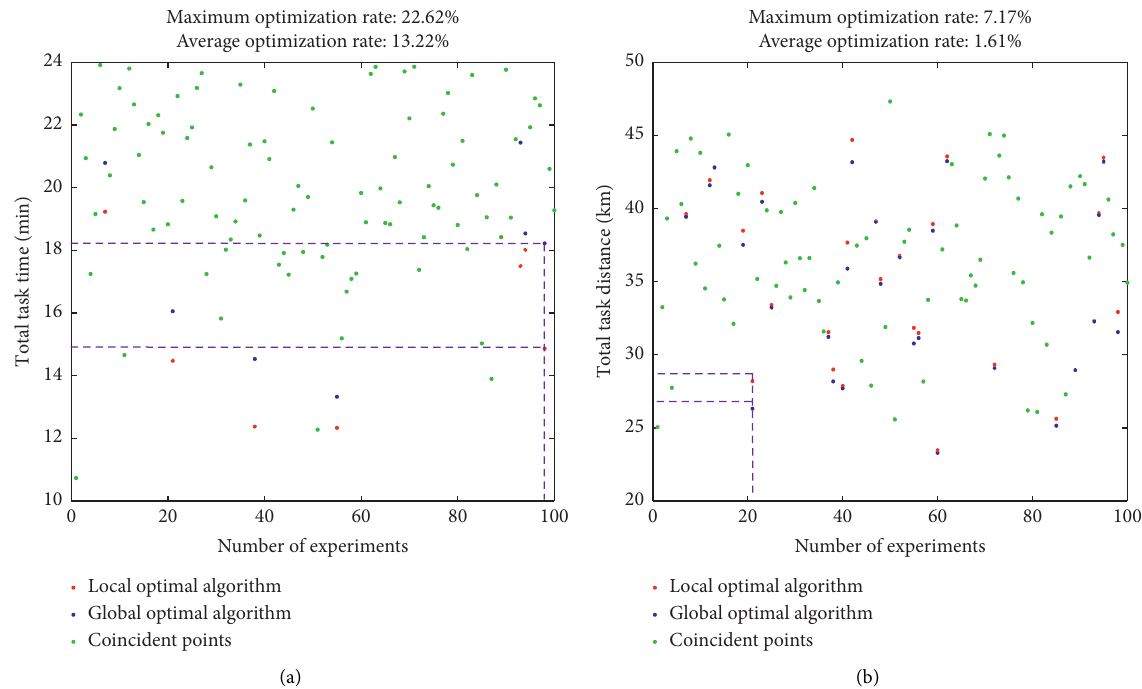
Figure 9: The results of two algorithms when R � 3 km: (a) total task time of two algorithms; (b) total task distance of two algorithms. Maximum optimization rate: 22.62%; maximum optimization rate: 7.17%